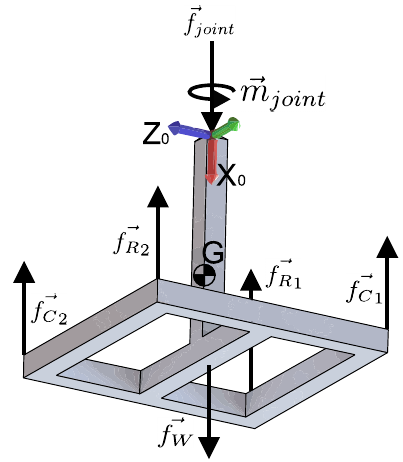
Figure 5. Free-body diagram of the moving